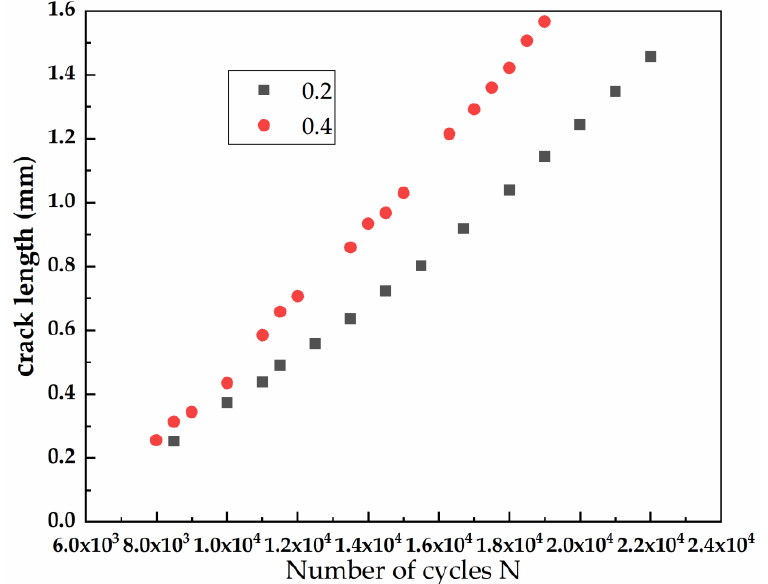
Figure 8. The FCG rate under two stress ratios.